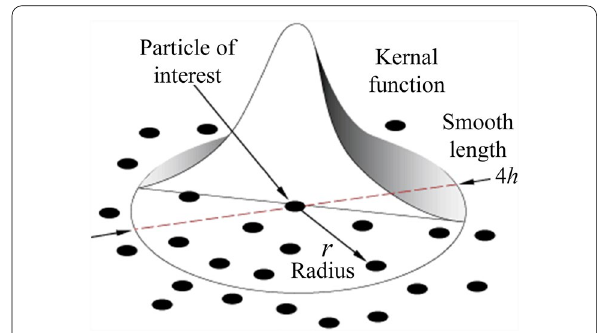
Figure 1 Smoothed particle and its support domain